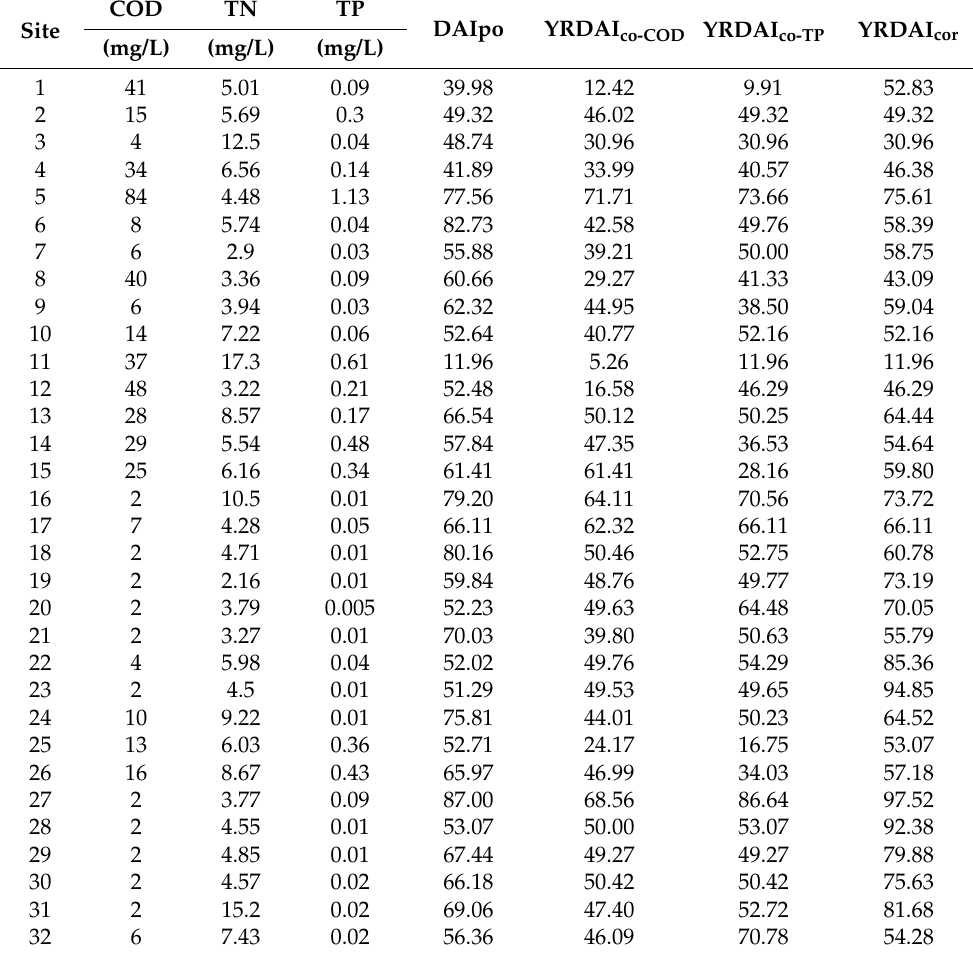
Table 1. Pollutants and diatom index scores in the Yuqiao Reservoir watershed,